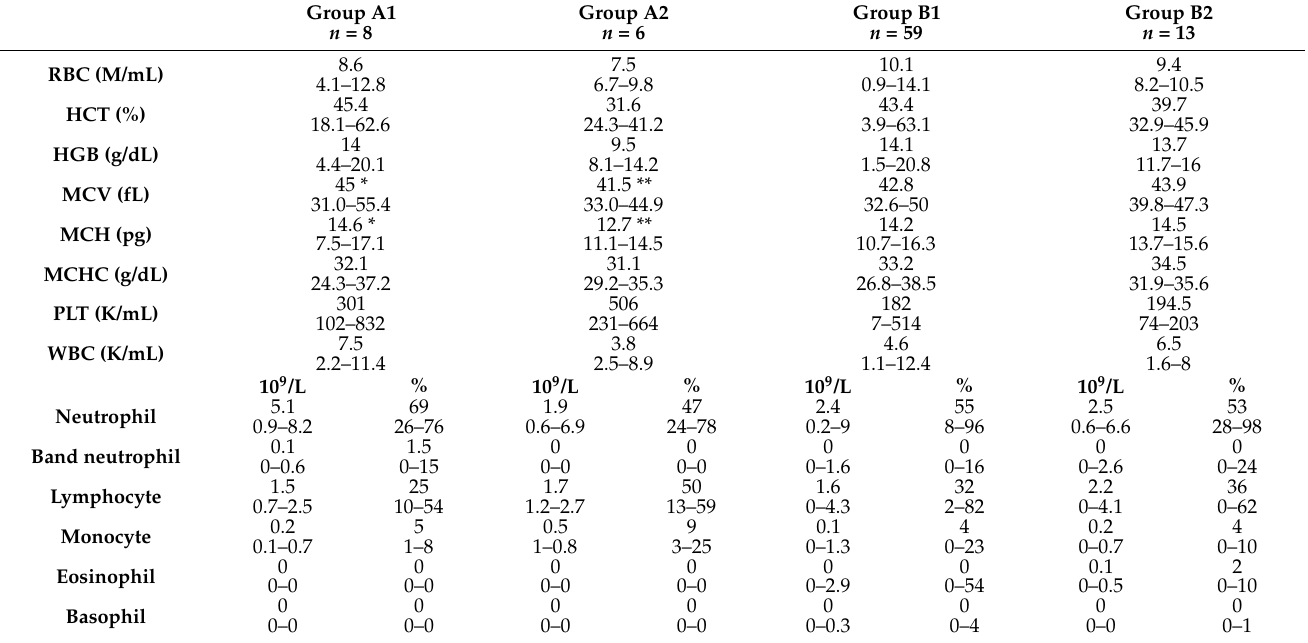
Table 4. Haematological parameters and differential cell counts assessed in the cohort of 86 patients categorised into groups.